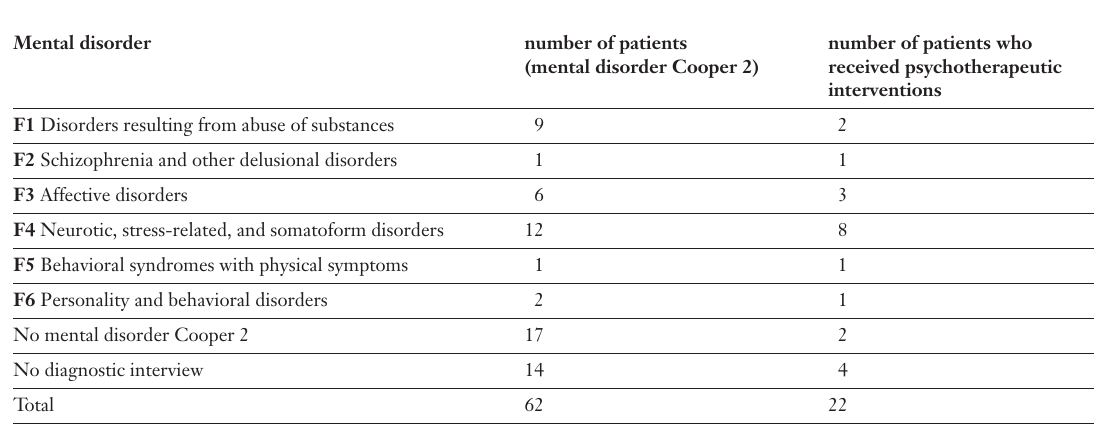
Need for psychother- apy and performance of psychotherapeutic interventions (n = 41).